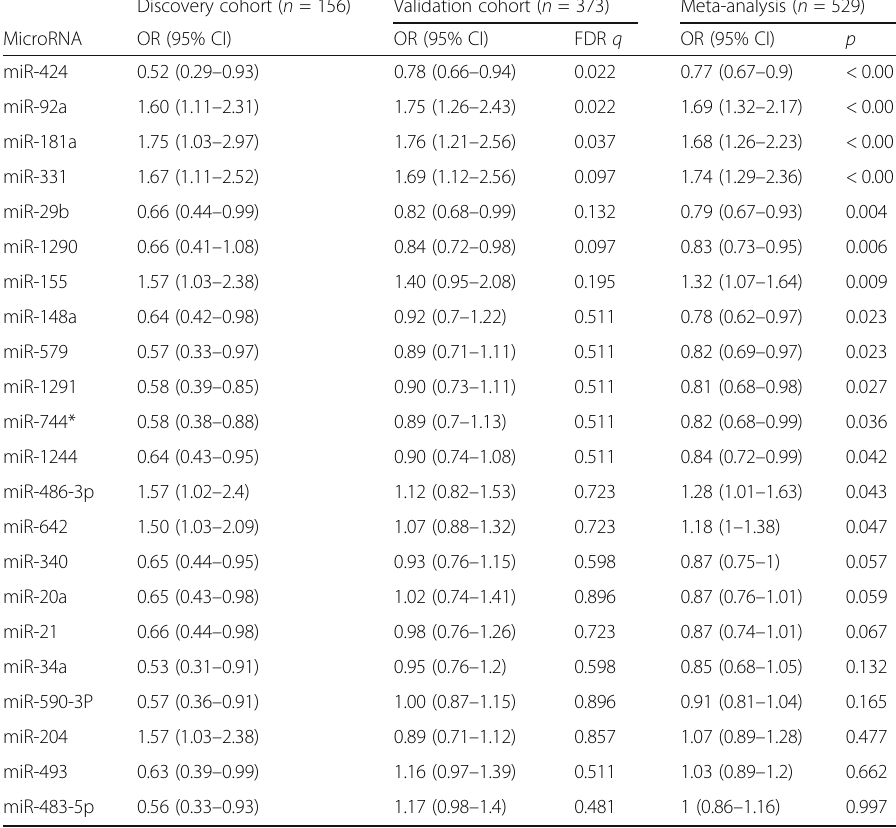
Table 1 miRNA associations with ARDS in discovery cohort, validation cohorts, combined cohorts, and meta-analysis Discovery cohort ( n =